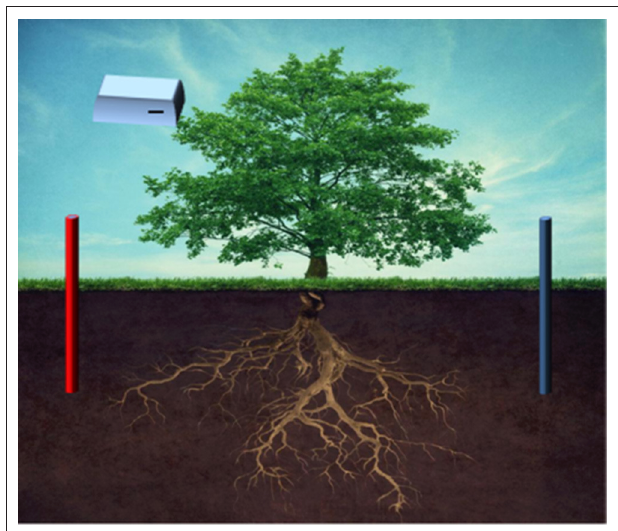
FIGURE 4 | Schematic diagram of electro-kinetic coupled/enhanced phytoremediation (Source: Mao et al., 2016) Copyright 2018,